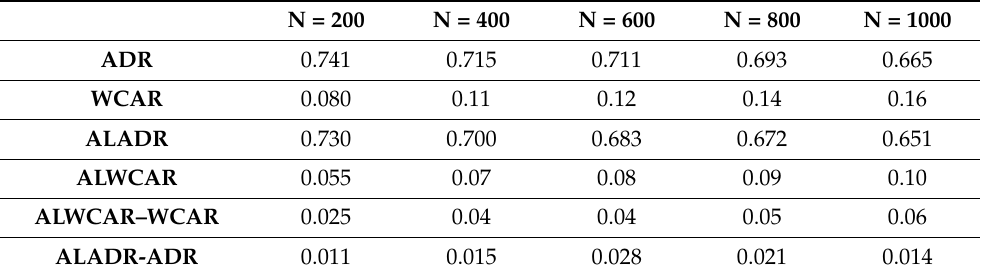
Table 3. Comparative analysis of detection ratios with variations in the number of nodes.